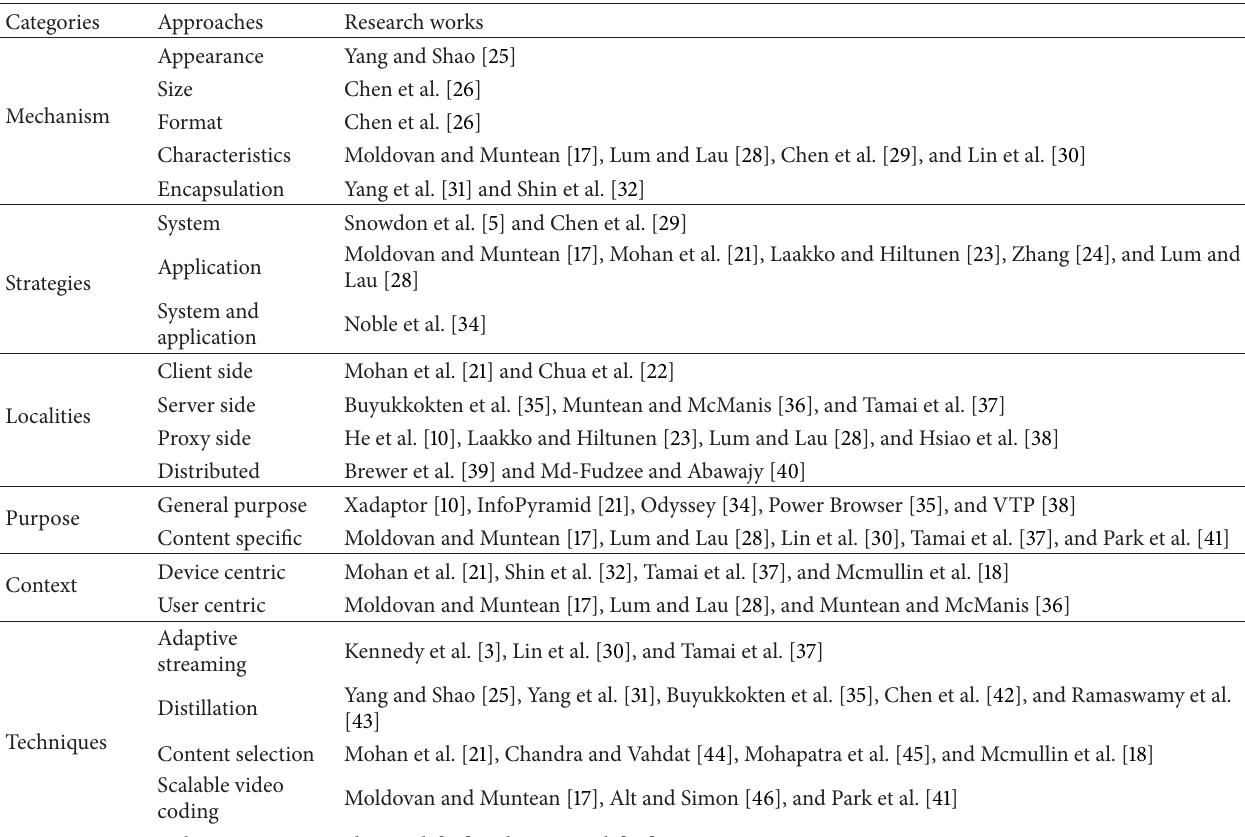
Table 1: Categories in energy-aware content